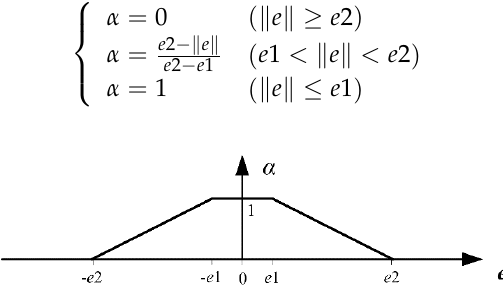
Figure 1. Relationship curve of α and e used in this paper.